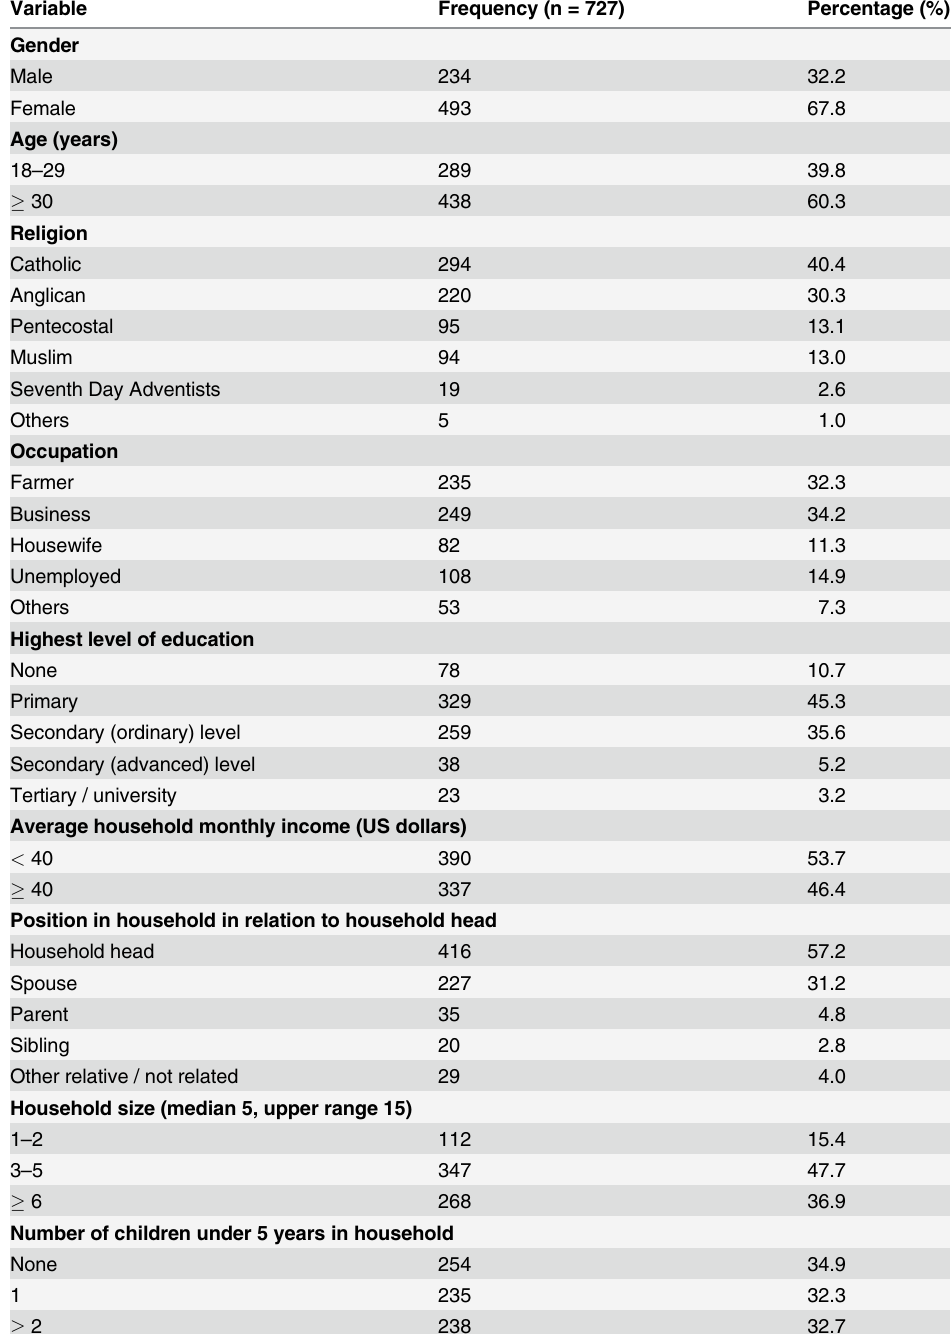
Table 1. Socio-demographic characteristics of